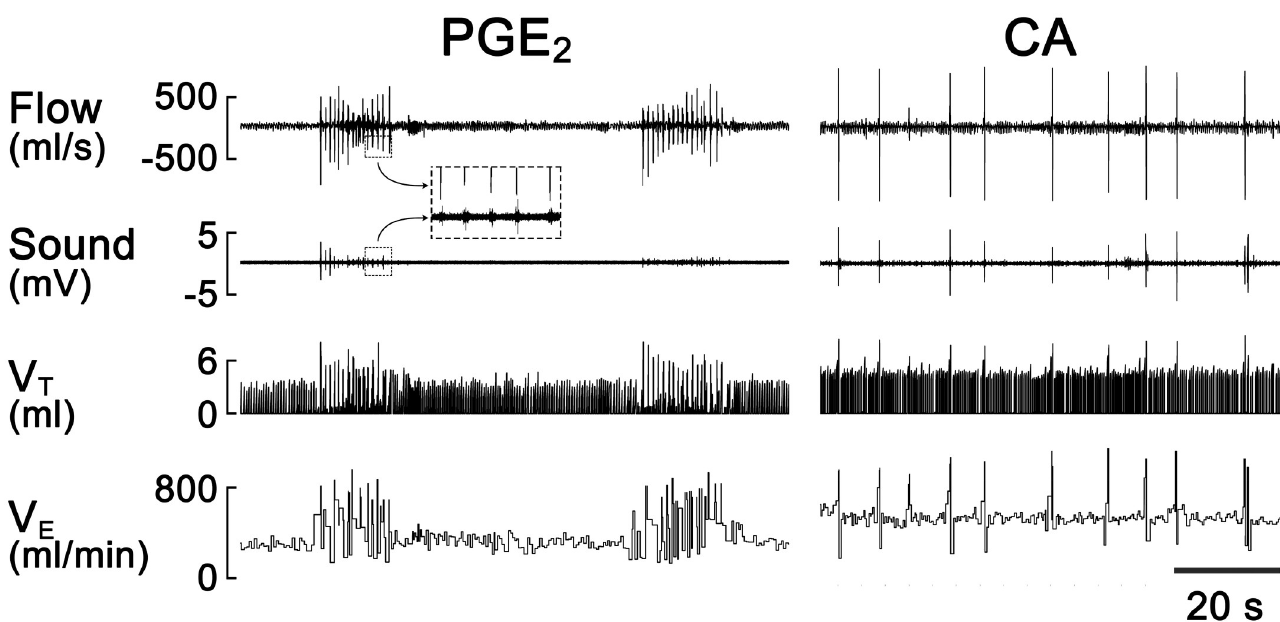
Fig 1. Comparison of the typical cough responses to PGE 2 and CA in two unanesthetized guinea pigs respectively. The traces from top to bottom are air flow, sound, tidal volume (V T ), and minute ventilation (V E ). The insert of a dash-lined box shows the enlarged flow and sound signals.